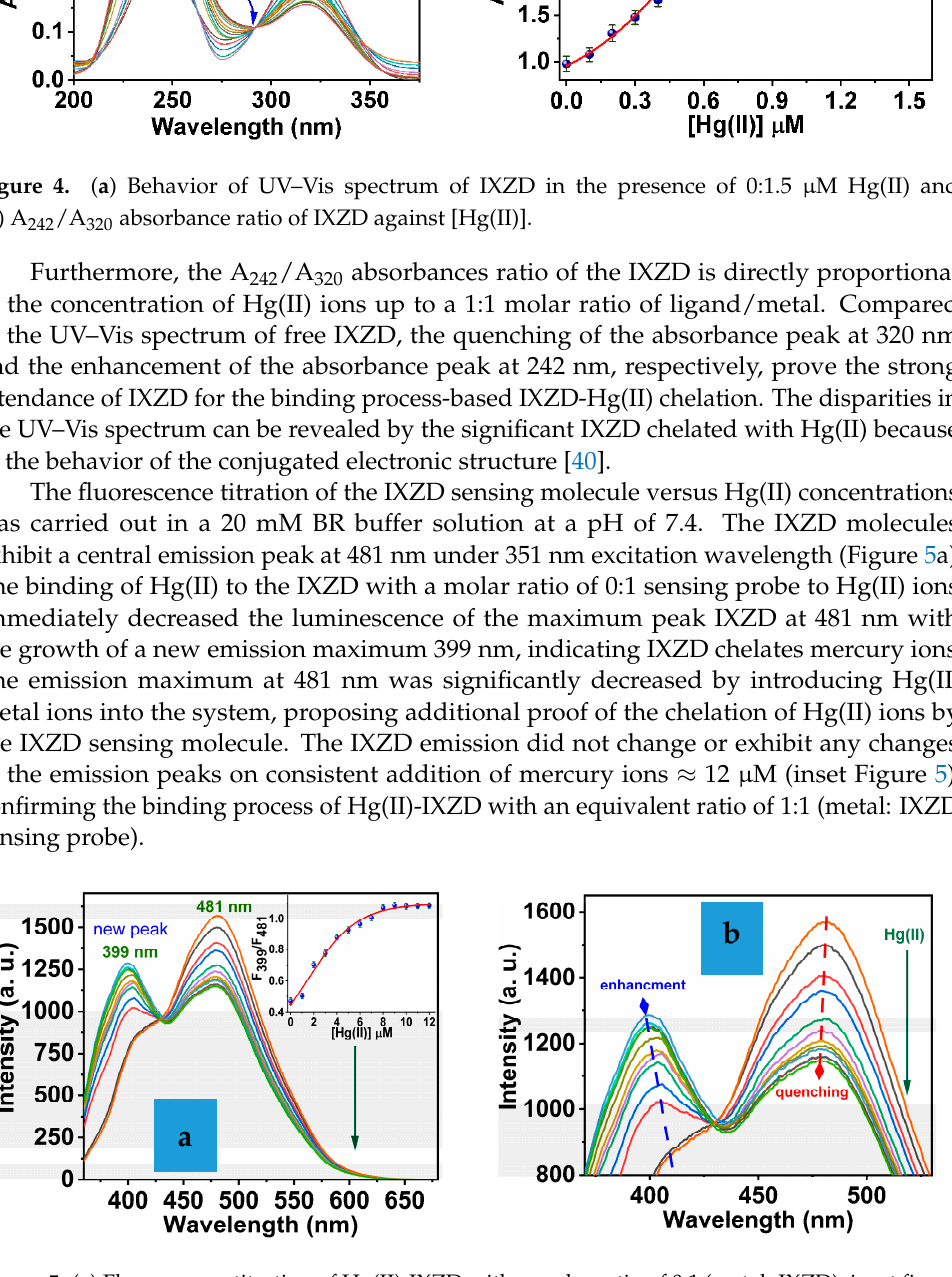
Figure 5. ( a ) Fluorescence titration of Hg(II)-IXZD with a molar ratio of 0:1 (metal: IXZD); inset figure represents the IXZD emission intensities ratio at 399 and 481 nm versus [Hg(II)]; ( b ) IXZD emission intensities scope at 399 nm and 481 nm, respectively.